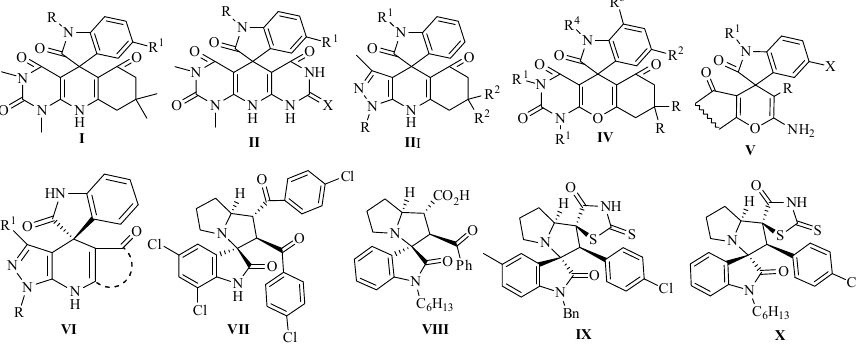
Figure 1. Outstanding examples of spirooxindoles obtained by multicomponent reactions.